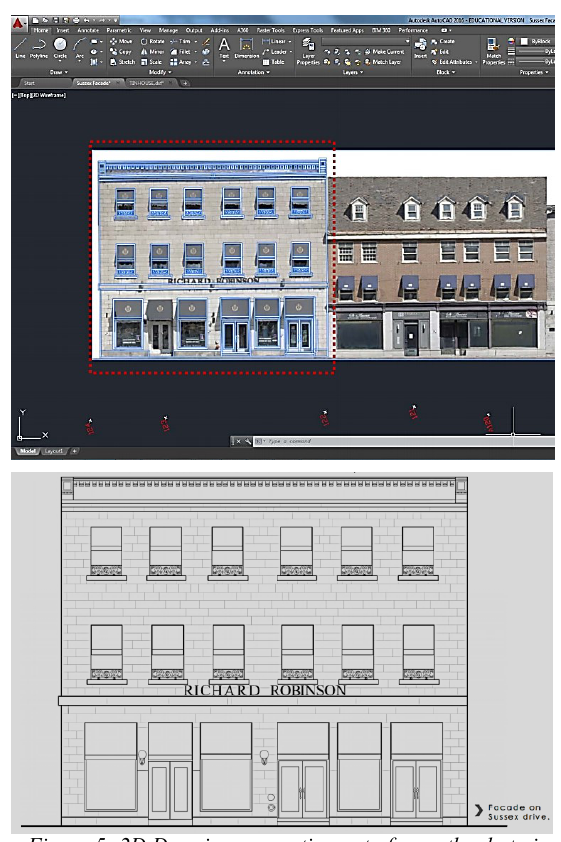
Figure 5: 2D Drawing generation out of an orthophoto in CAD environment.